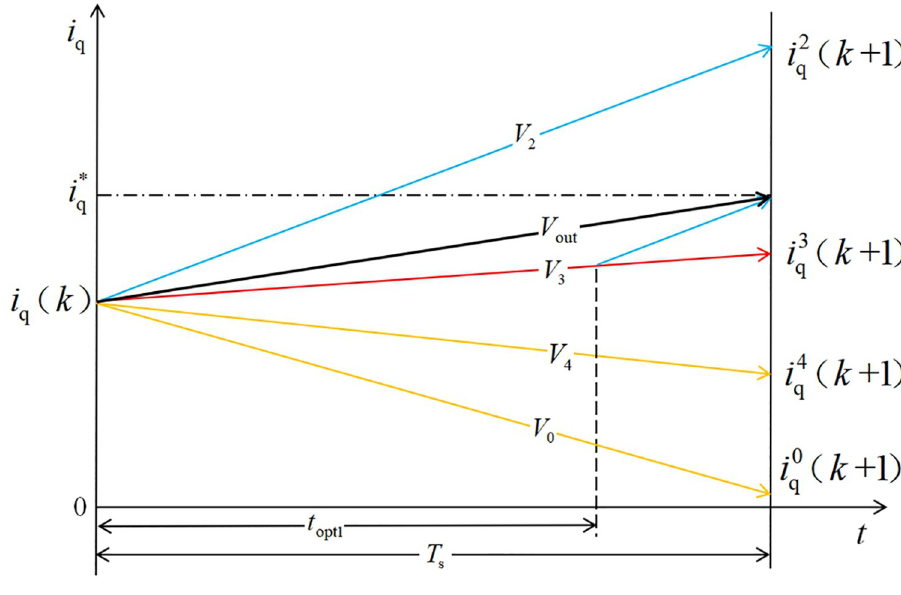
Fig 5. Selection of the second voltage